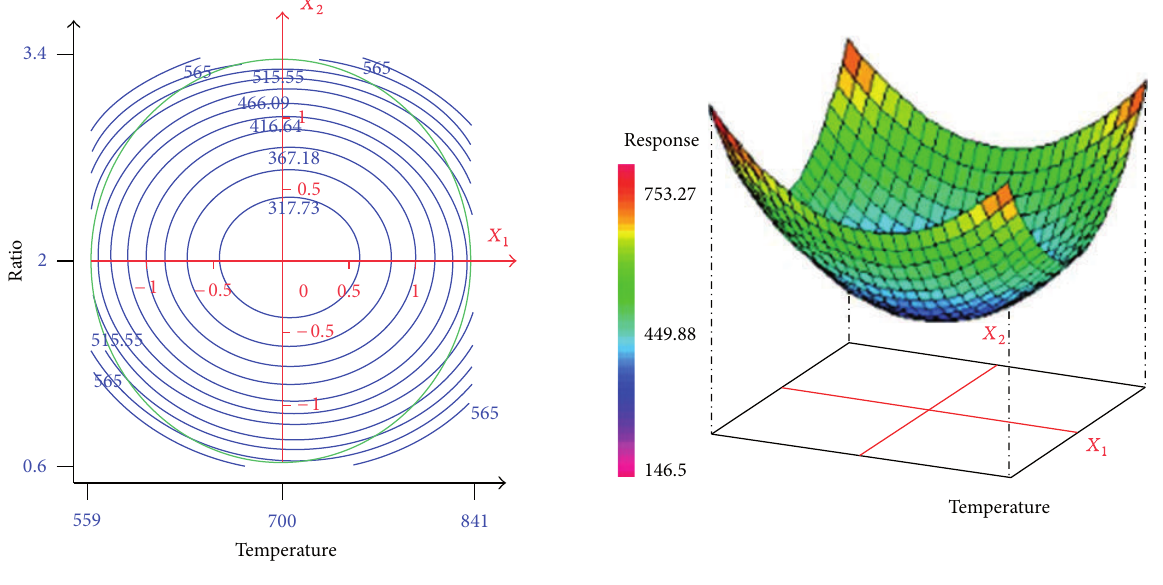
F 3: Variation of the methylene blue adsorption, MB/AC-H